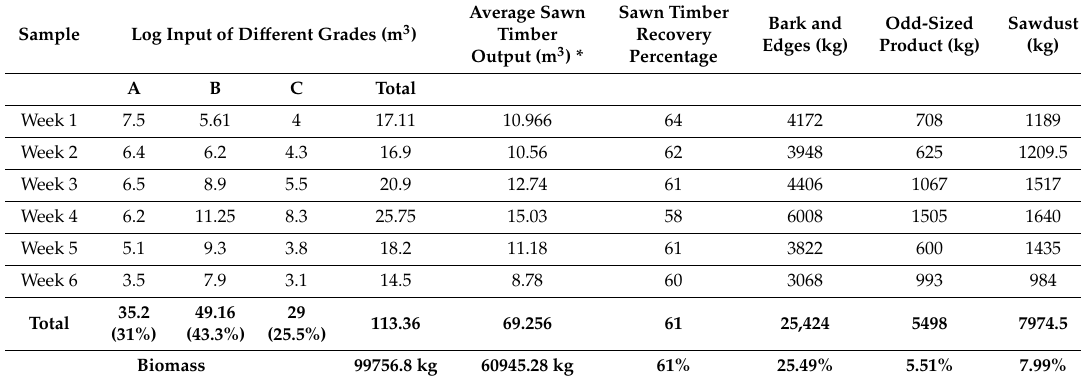
Table 1. Actual wood product recovery of Tarai Sal from a company-owned sawmill in